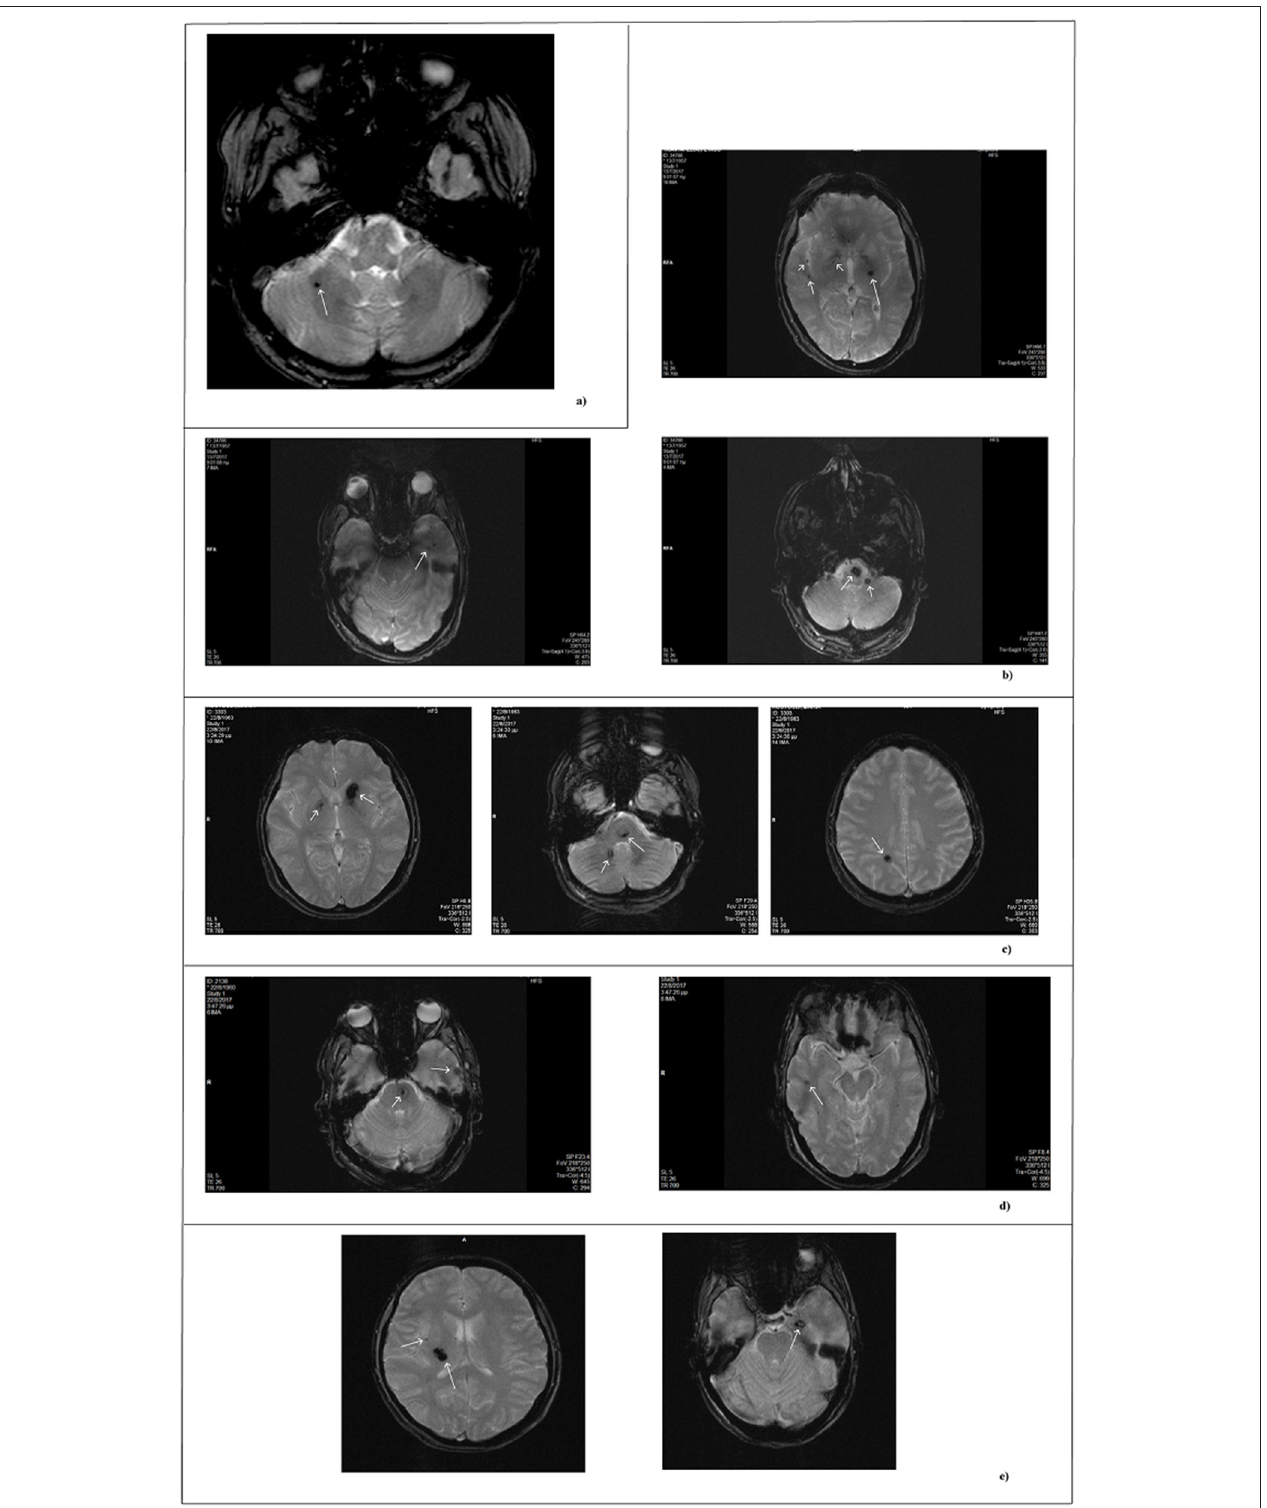
FIGURE 1 | MRI scan of patients. MRI images obtained by T2- weighted gradient echo sequences. Each panel refers to a single patient. (a) Single lesion detected in the sporadic patient. (b–e) Lesions of affected family members. In reference to Figure 2 : (b) II-1; (c) II-3; (d) II-4; (e) III-13.